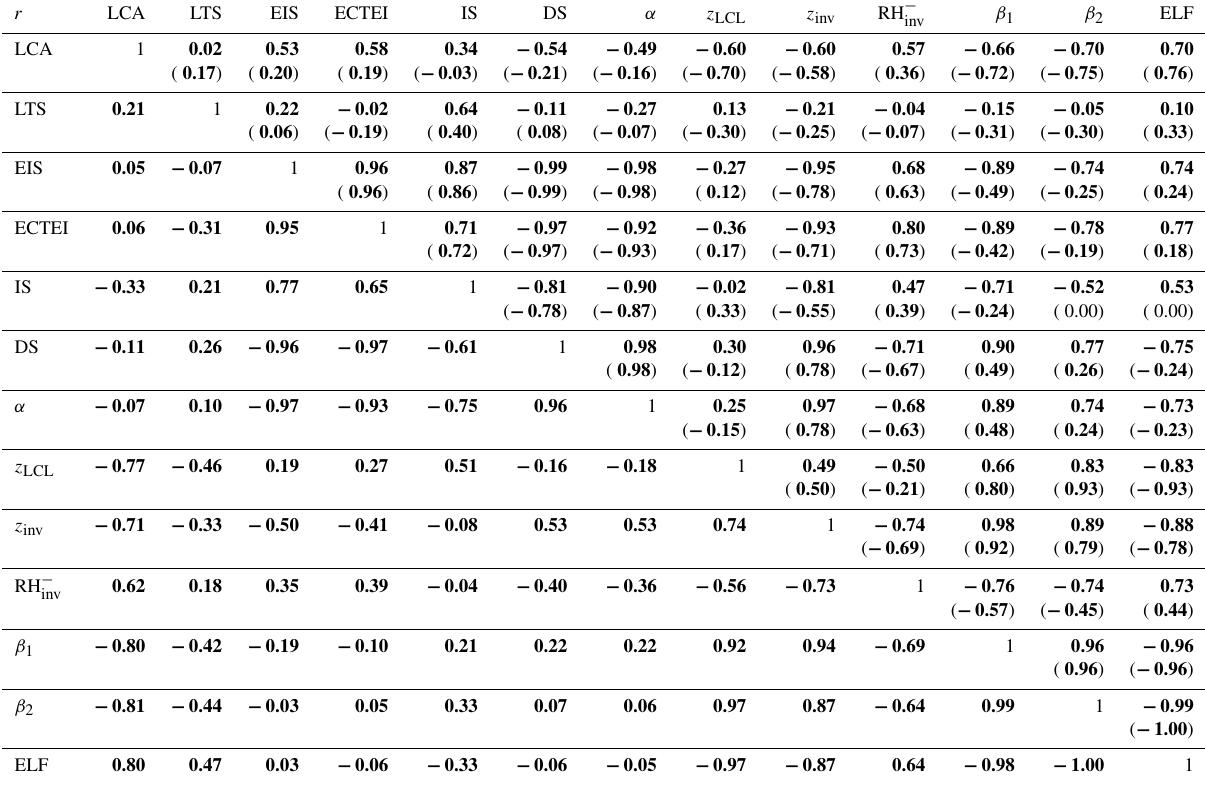
Table 3. Combined spatial–seasonal–interannual correlation coefficients of the seasonal LCA fitted to the individual proxy with the same convention as Table 1. All seasonal data (DJF, MAM, JJA, SON) in each year in each 5 ◦ latitude × 10 ◦ longitude grid box are used. Only the data satisfying 0 < α < 1 are used for this